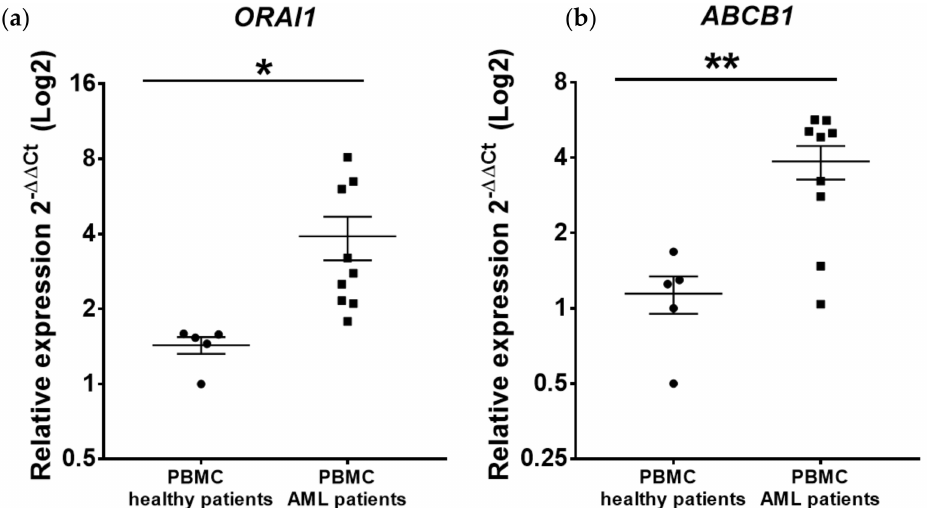
Figure 1. Expression of ORAI1 and ABCB1 in human AML primary cells compared with healthy primary PBMCs. qRT–PCR detection of ORAI1 ( a ) and ABCB1 ( b ) gene expression in AML primary cells isolated from 9 patients at disease diagnosis compared with normal primary PBMCs isolated from 5 healthy donors. The expression levels of ORAI1 and ABCB1 relative to beta-2 microglobulin ( B2M ) for each sample were normalized to the ORAI1 and ABCB1 levels in healthy PBMCs. The relative expression ratio for each gene was calculated by the 2 − ∆∆ Ct method. * p < 0.05, ** p < 0.01 compared with healthy